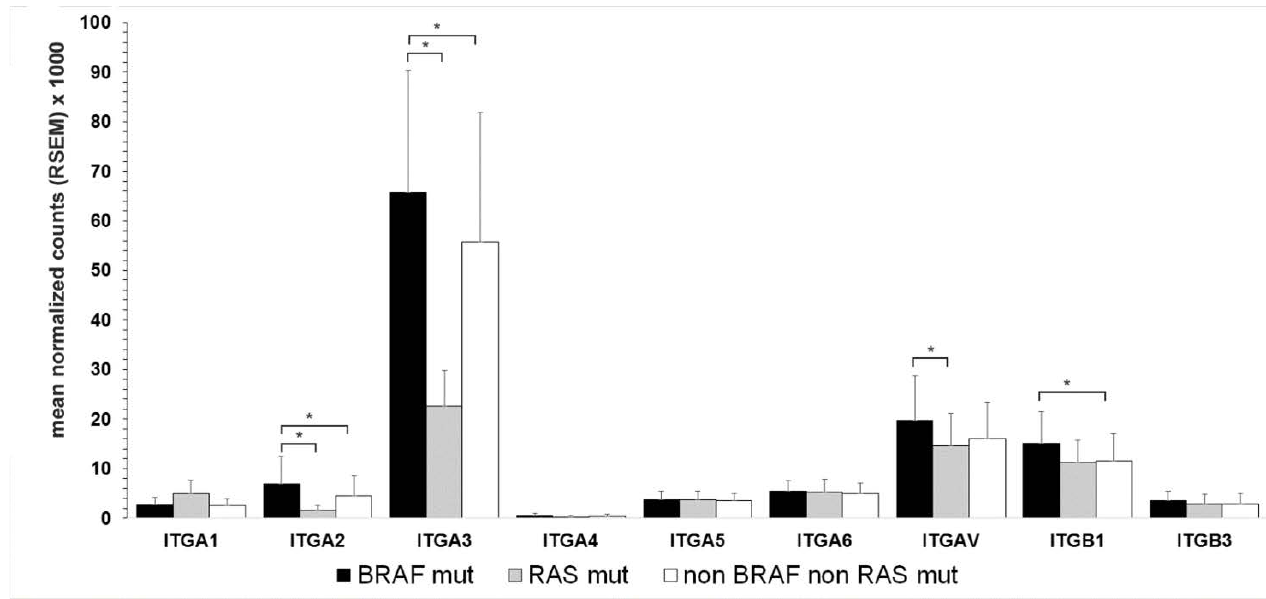
Figure 1. Integrin subunits expression in TCGA database. Mean and standard deviation of mRNA integrin subunits of papillary thyroid carcinoma PTC (black bars, n = 321) and normal thyroid tissue (NT, gray bars, n = 58). * Wilcoxon p < 0.001.